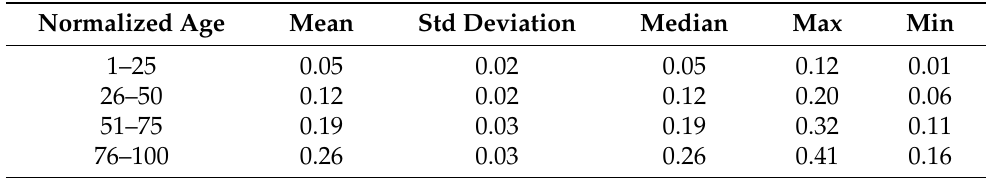
Table 3. Estimated cost (expressed in USD) of sending reports to the cloud using a satellite